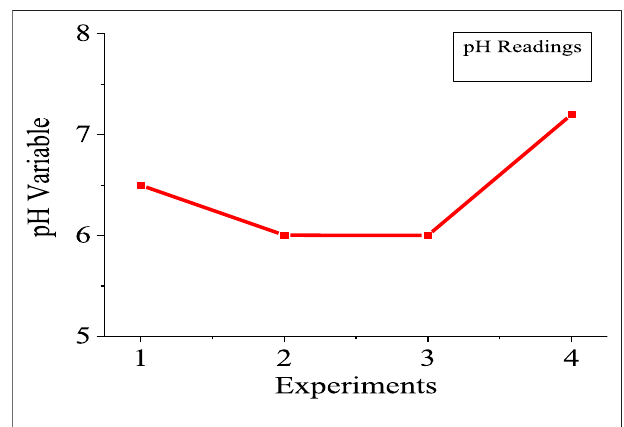
FIGURE 6 | pH variable of the